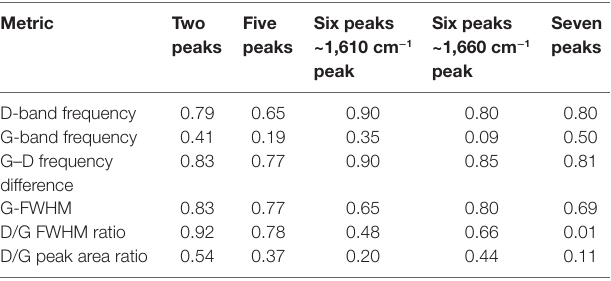
Table 4 | Coefficients of determination ( R 2 ) generated from correlation of Raman spectral metrics with VRo% using different peak-fitting strategies. Metric